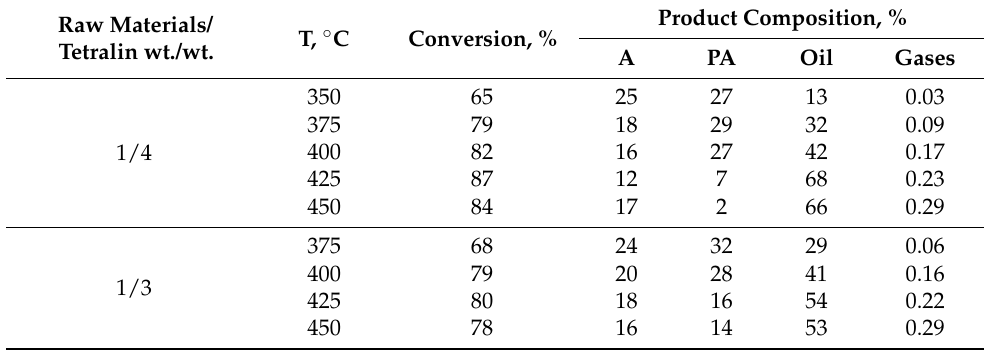
Table 2. The main characteristics of the thermal dissolution of biochar in tetralin. Raw Materials/ T, ◦ Tetralin wt./wt.